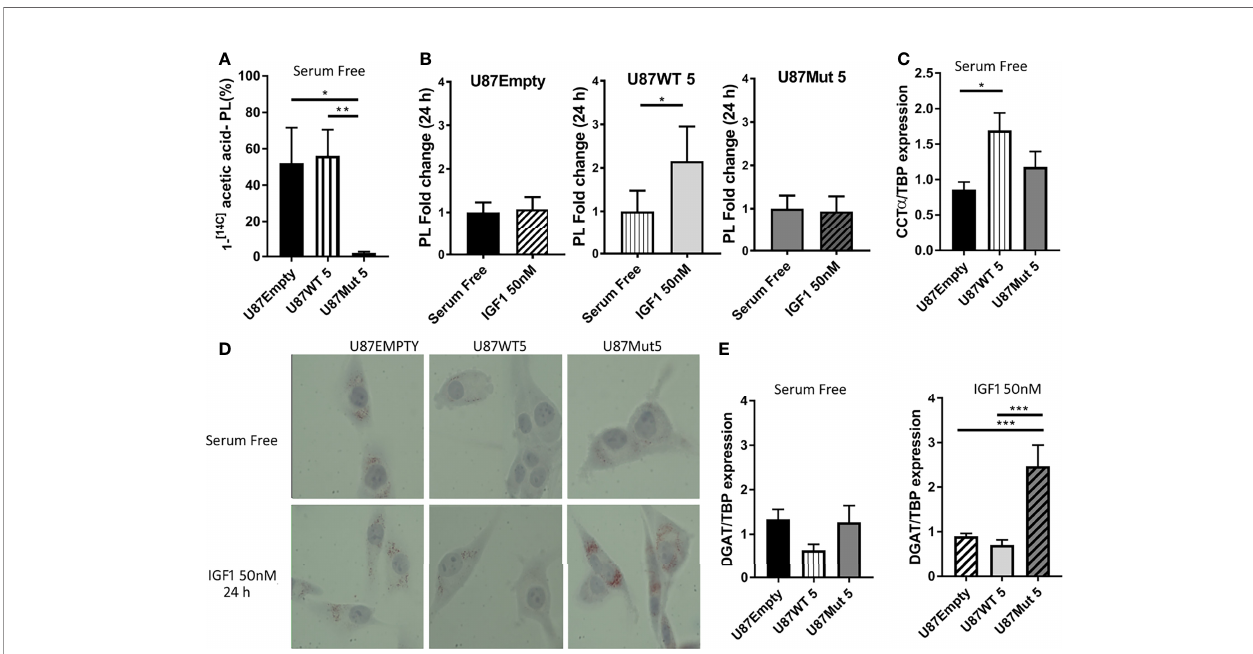
FIGURE 4 | Effects of IGF1R localization over phospholipid and triglyceride synthesis. U87Empty, U87WT, and U87Mut cells were cultured 24 h in serum-free medium or with 50-nM IGF1 stimulation (IGF1) or pre-incubated (1 h) with 0.5 m M OSI906 (IGF1+OSI) in the presence of 1- [14C] acetic acid. Lipids were extracted and resolved by thin-layer chromatography, and the radioactivity associated with each condition was quanti fi ed. Three independent experiments were performed. (A) 1- [14C] acetic acid incorporated to newly synthesized phospholipids. The results are expressed as percentage of 1- [14C] acetic acid incorporated into phospholipid fraction normalized by the number of cells seeded/well. Values are presented as mean ± SD (* p < 0.05, ** p < 0.005, ANOVA, Tukey ’ s post-test). (B) Changes in the amount of phospholipids in response to 24-h IGF1 stimulation in each cell line. The results are presented as fold change compared to control conditions (serum-free). Values are expressed as mean ± SD (* p < 0.05, Mann – Whitney test). (C) U87Empty, U87WT, and U87Mut cells were cultured 24 h in serum-free medium. CCT a mRNA expression was calculated by rqPCR by the relative quantitation method, and the results are presented as fold change compared to U87Empty cells. Values are expressed as mean ± SD of three independent experiments performed in triplicates (* p < 0.05, ANOVA, Tukey ’ s post-test). (D) Representative picture of lipid droplets visualized by oil red O (ORO) in U87Empty, U87WT, and U87Mut cells after 24 h of incubation in serum-free medium or with 50-nM IGF1 stimulation (IGF1). (E) DGAT mRNA expression of U87Empty, U87WT 5, and U87Mut 5 cells incubated in serum-free medium (left) or with 50-nM IGF1 stimulation (IGF1) (right). The results are presented as fold change compared to U87Empty cells. Values are expressed as ± SD of three independent experiments performed in triplicates (*** p < 0.001, ANOVA, Tukey ’ s